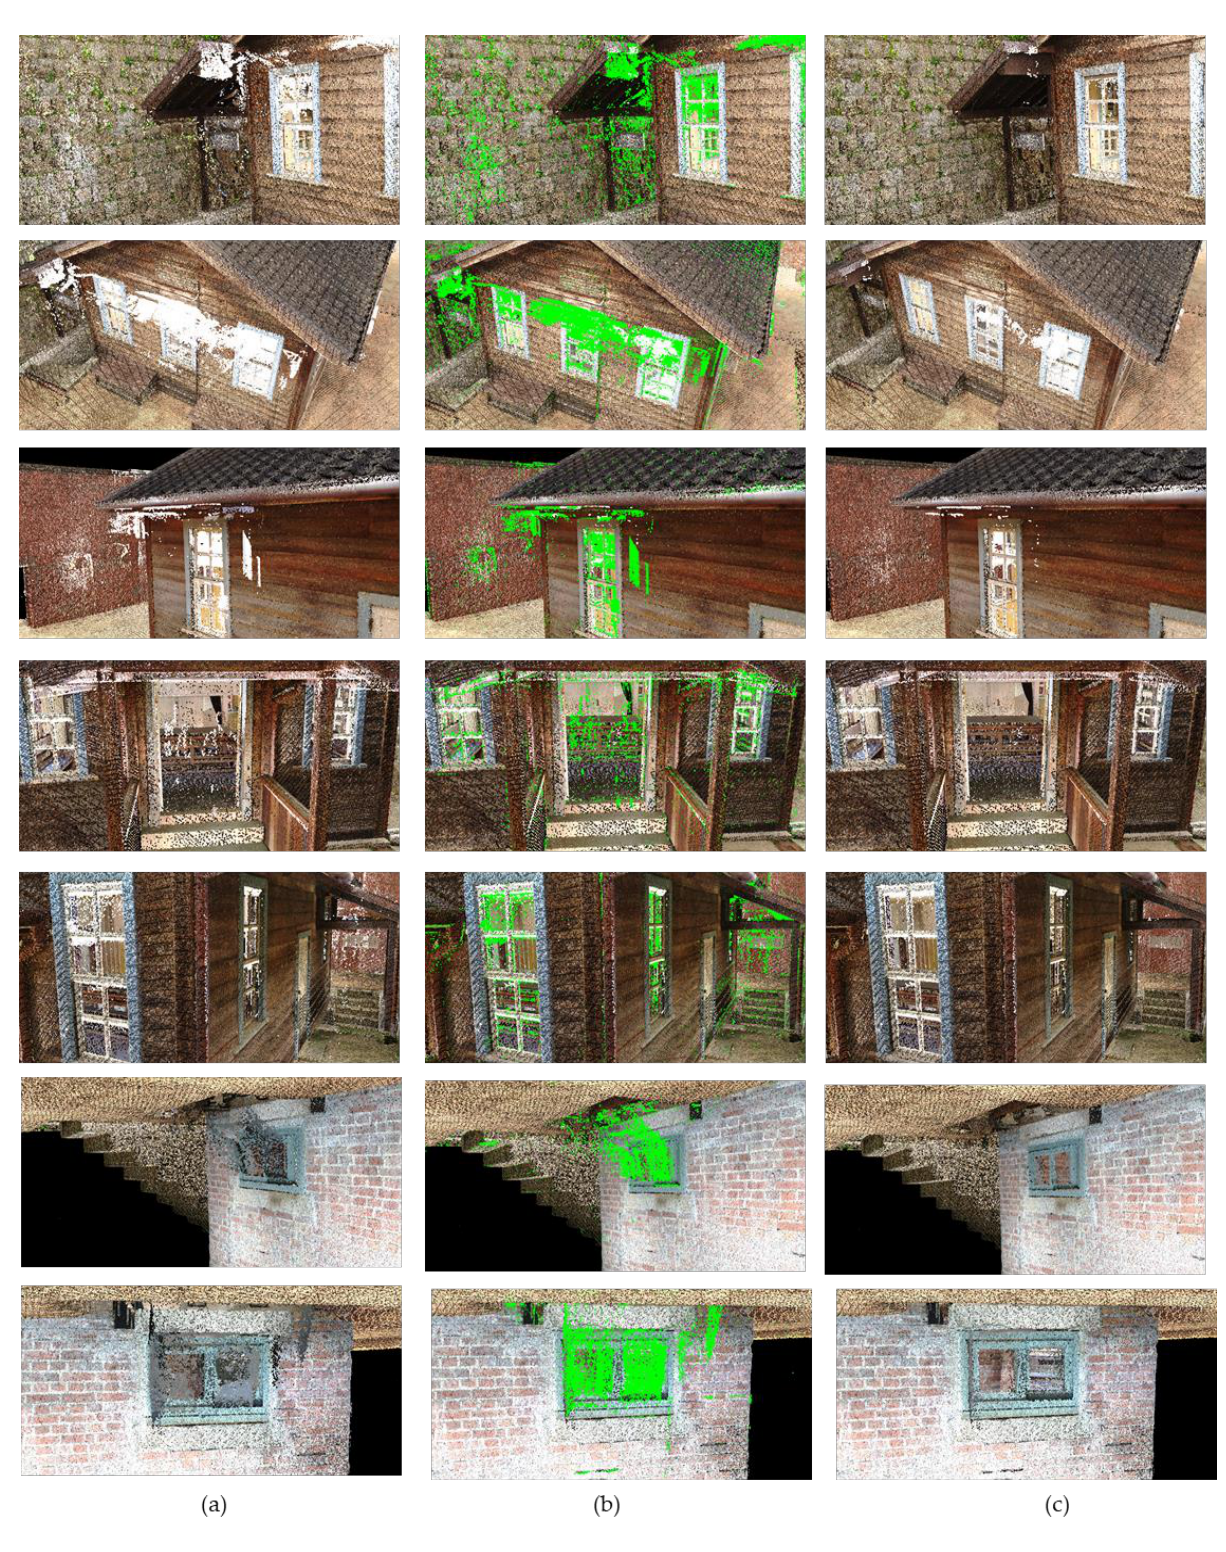
Figure 11. Results of the proposed method. ( a ) is the original point-cloud image, ( b ) the green part of the figure is the reflected noise region detected by our method, and ( c ) is the result obtained after denoising using our method.